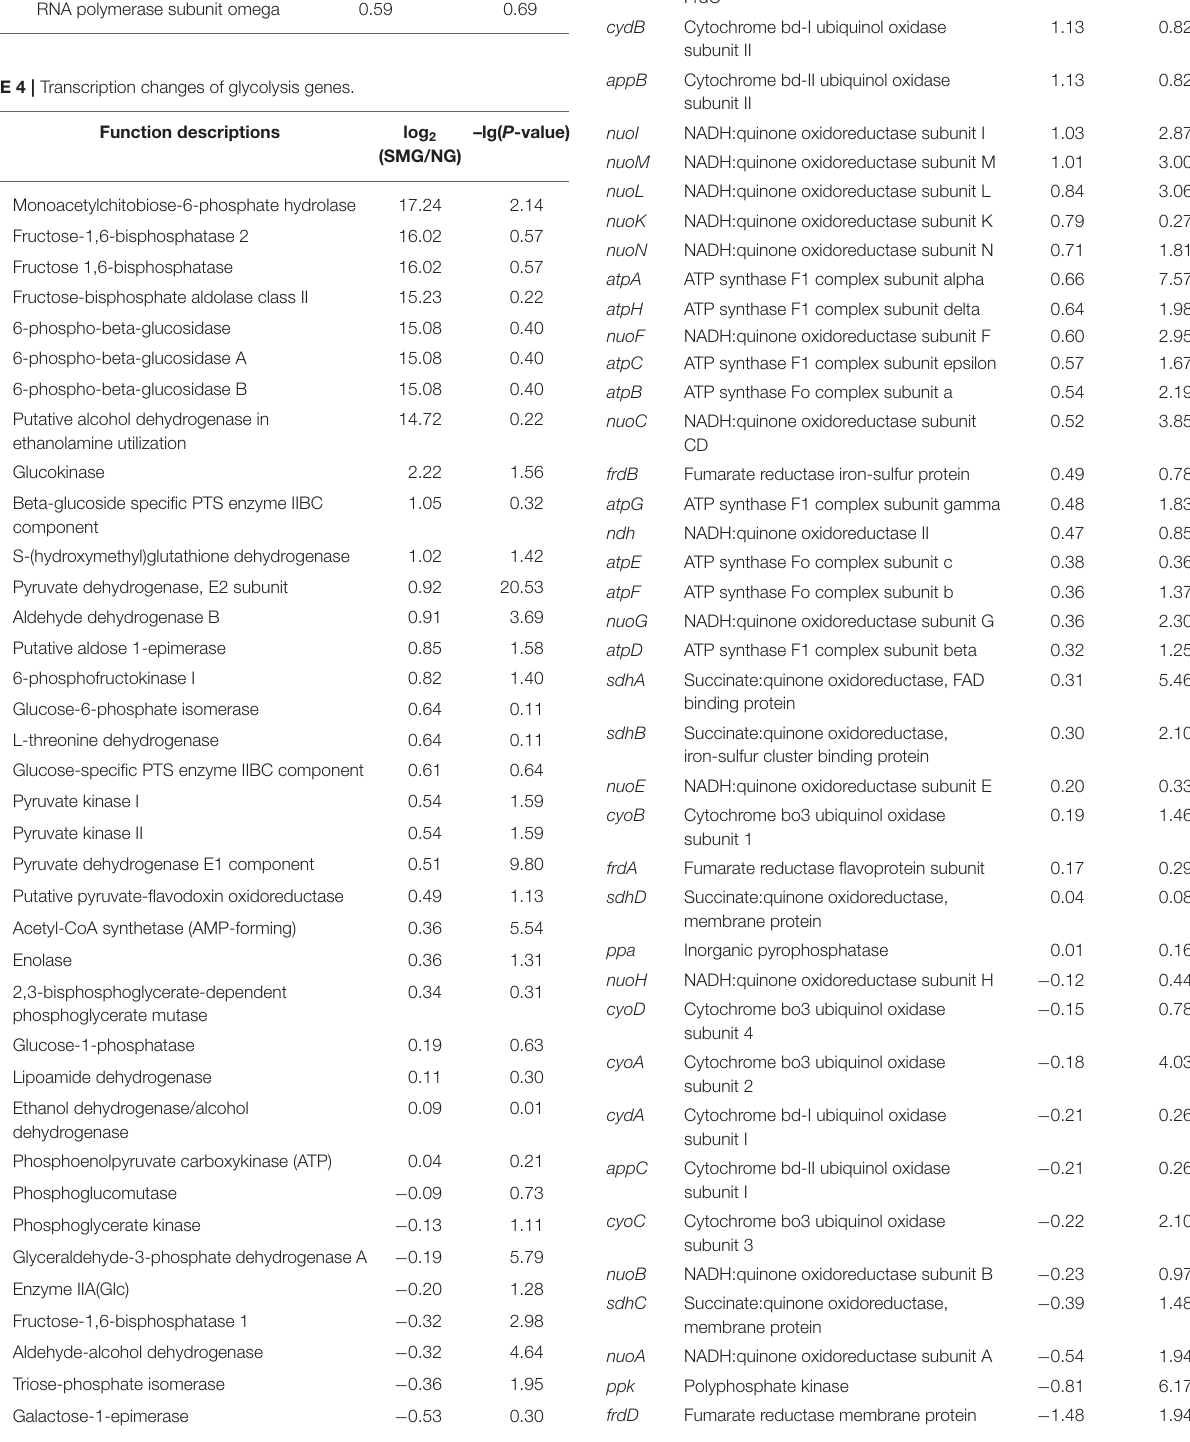
TABLE 4 | Transcription changes of glycolysis genes.